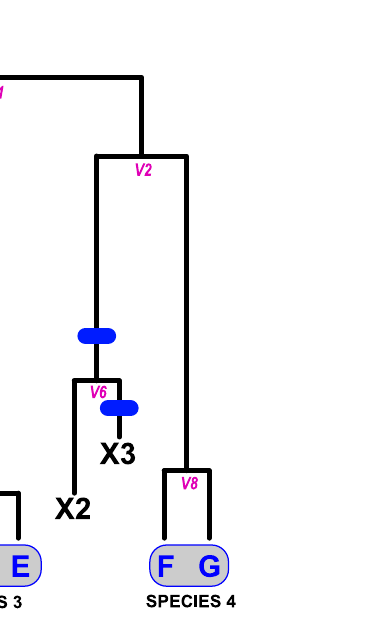
Fig 1. The Protracted Birth Death (PBD) model of the speciation process [26, 27] implemented in DELINEATE separately models lineage splitting and completion of speciation events, such that “speciation” is an extended process. For example, considering a phylogeny of population lineages inferred under the MSC [1, 28], the lineage splitting events correspond to the formation of new isolated population lineages (not species) through restrictions in gene flow in an ancestral population (e.g., V 1 ). These lineages may themselves give rise to other population lineages ( V 2 through V 9), or go extinct ( X 1 through X 3). Population lineages develop into an independent species at a fixed background rate, providing they are not otherwise lost (i.e., there is duration between the initiation and completion of speciation). Changes in status from incipient to full or good species are marked by speciation completion events, shown by the blue bars. Under the PBD, a “species” is thus made up of one or more population lineages not separated from one another by a speciation event. In this example, five speciation completion events divide the seven extant populations into four species: { A , B }, { C }, { D , E }, and { F , G